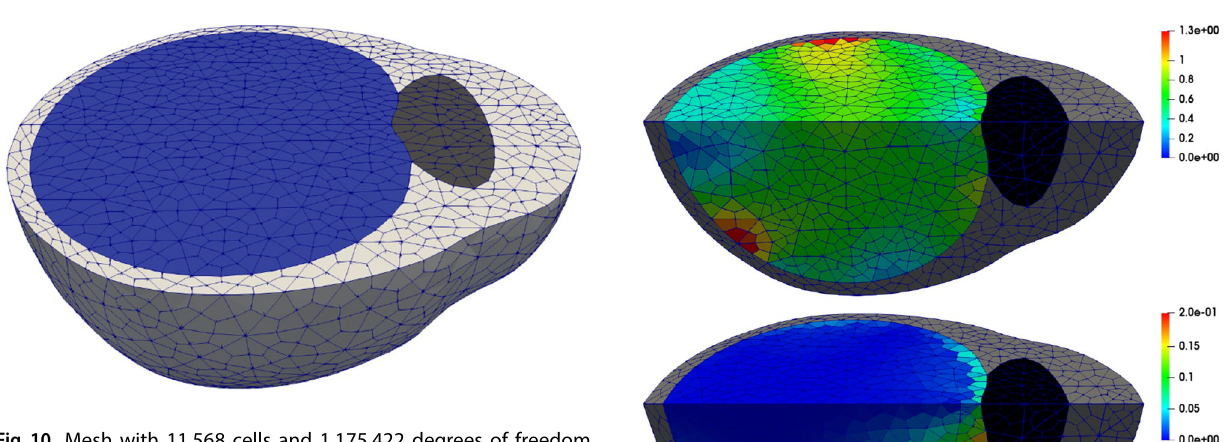
Fig. 10 Mesh with 11,568 cells and 1,175,422 degrees of freedom [304,053 (velocity), 304,053 (displacement), 20,704 (pressure), 546,612 (viscoelastic tensors)]